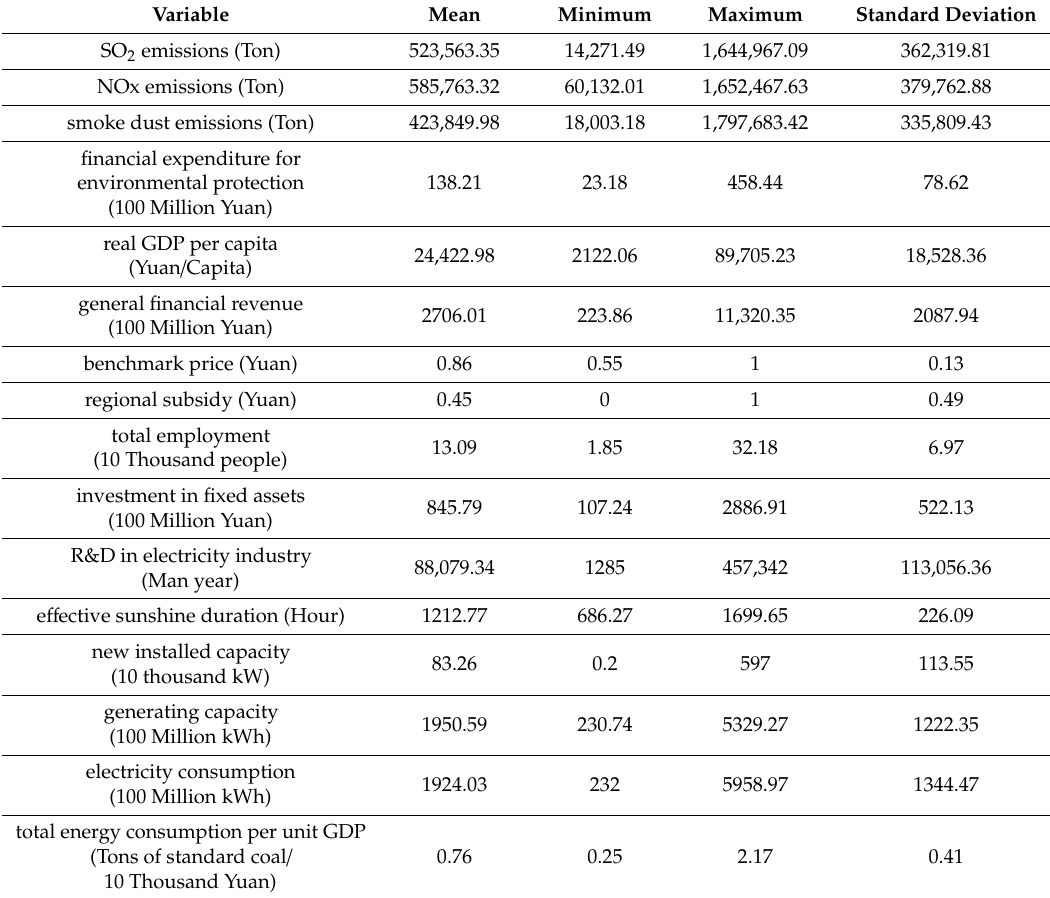
Table 2. Descriptive statistics of the data